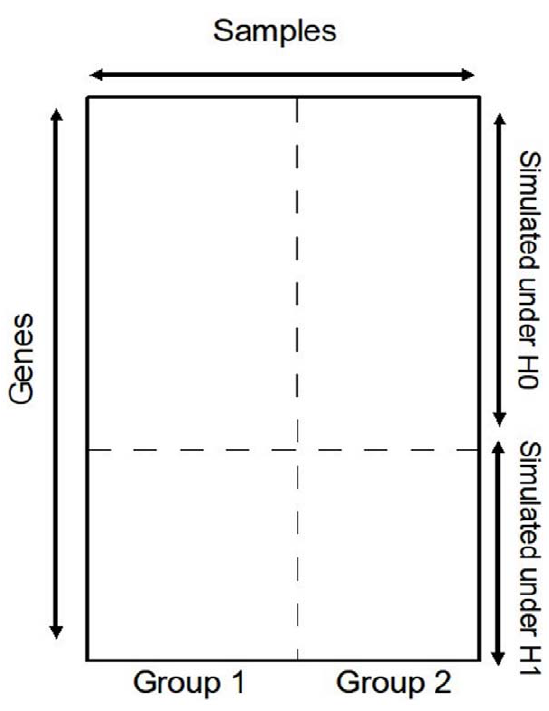
Figure 1. Data matrix resulting from simulations. Rows refer to genes simulated under H 0 and H 1 , columns refer to samples of both groups to compare.